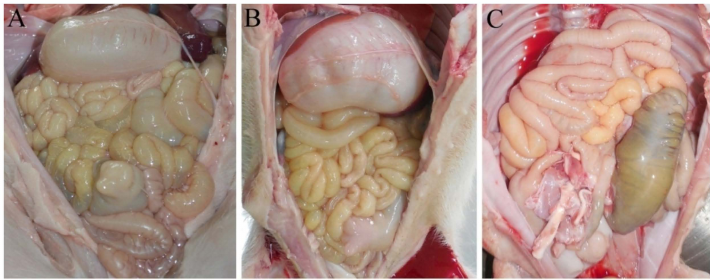
Figure 2. The necropsies results of pigs infected with YN15 ( A ), YN144 ( B ) and the control group ( C ).